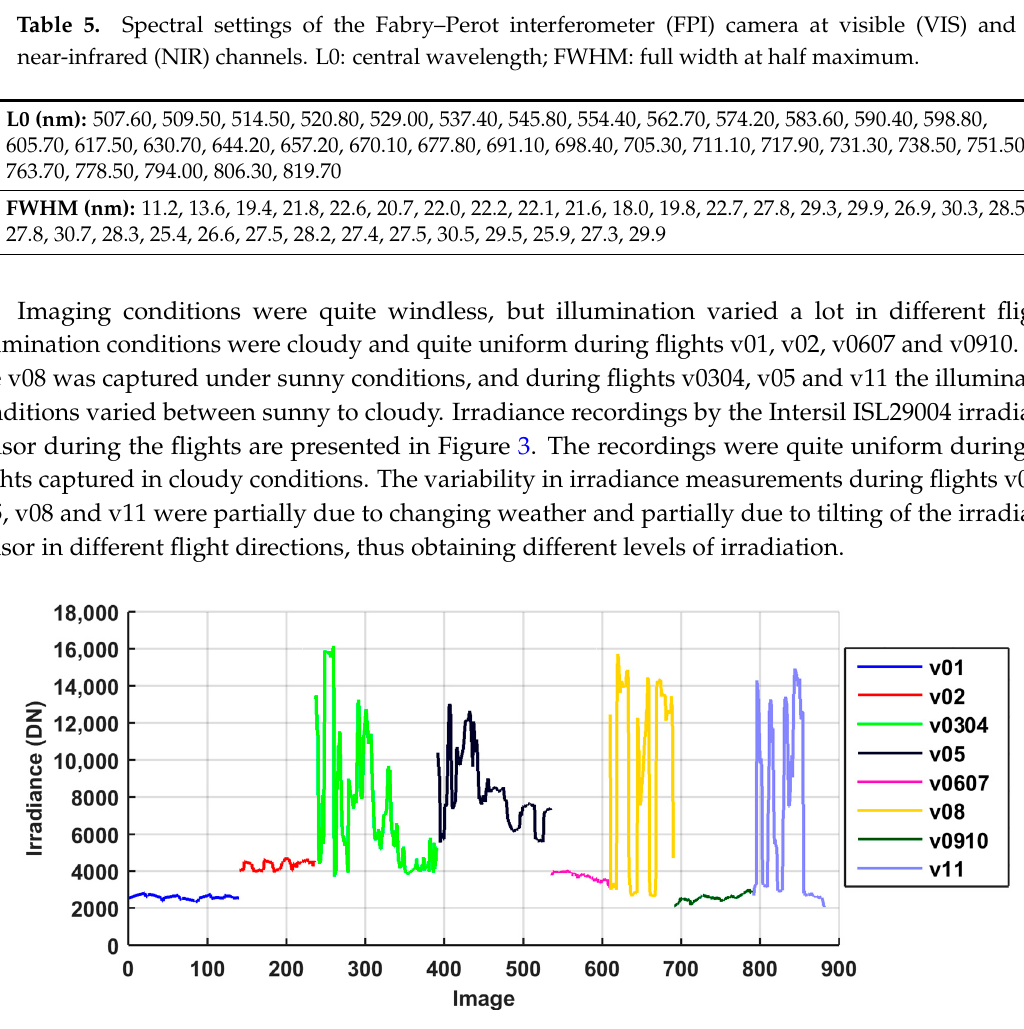
Table 5. Spectral settings of the Fabry–Perot interferometer (FPI) camera at visible (VIS) and near-infrared (NIR) channels. L0: central wavelength; FWHM: full width at half maximum.